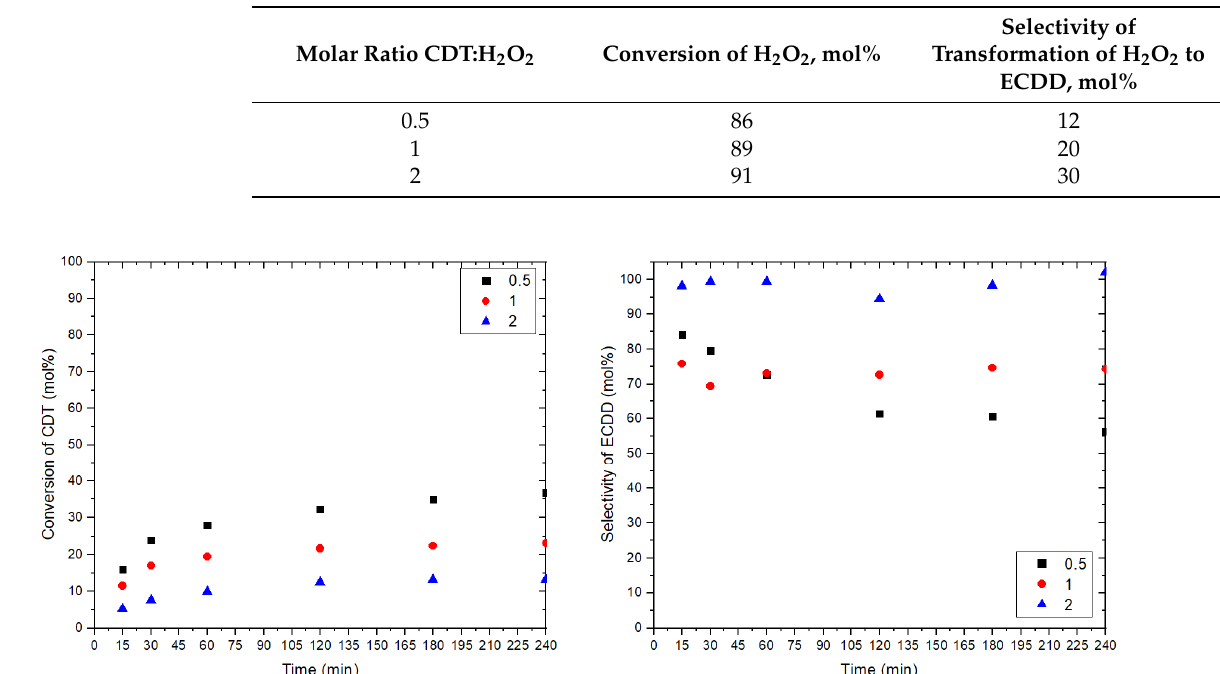
Table 2. Values of the conversion of H 2 O 2 and selectivity of transformation of H 2 O 2 to ECDD obtained after 4 h of performing the reaction with different molar ratios of CDT:H 2 O 2 . The reaction conditions were as described in Figure 12.